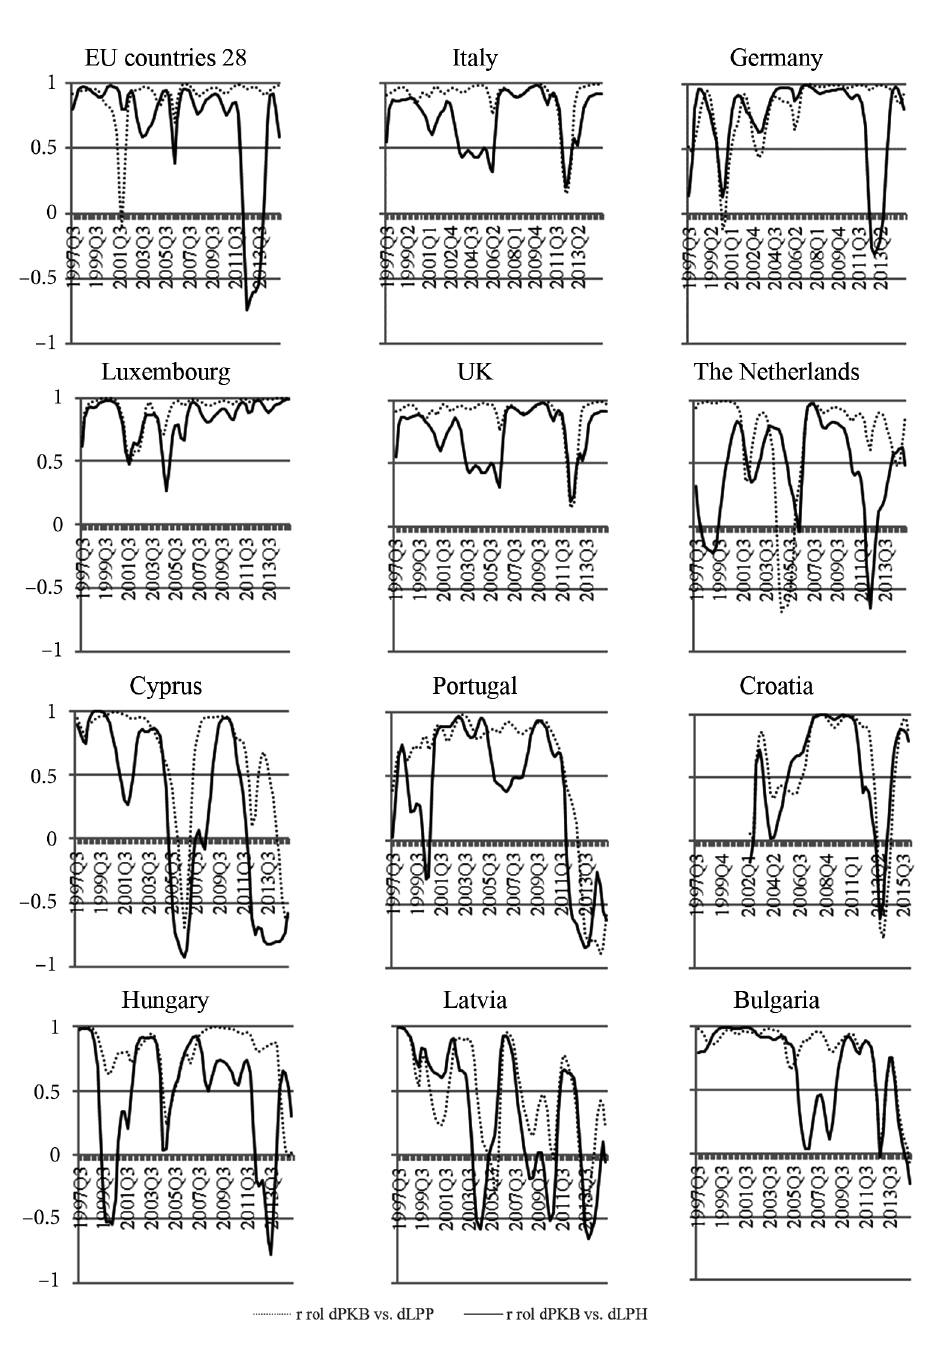
Figure 1. Pro-cyclicity of work productivity (rolling